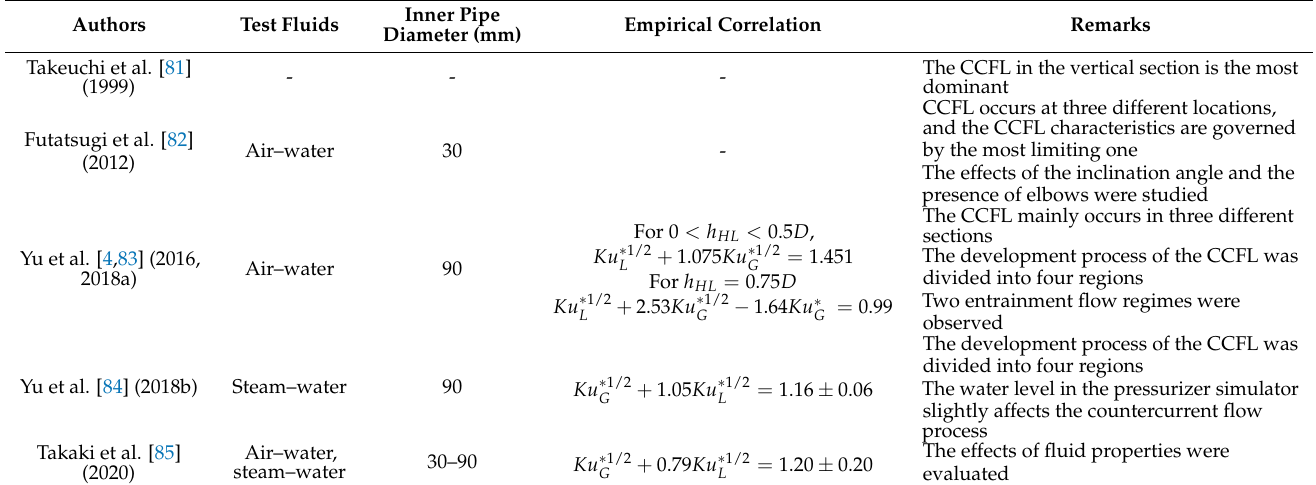
Figure 14. A model of a pressurizer surge line (Takeuchi et al. [81]). Table 6. Summary of the experimental investigations on the CCFL in the PWR pressurizer surge line.